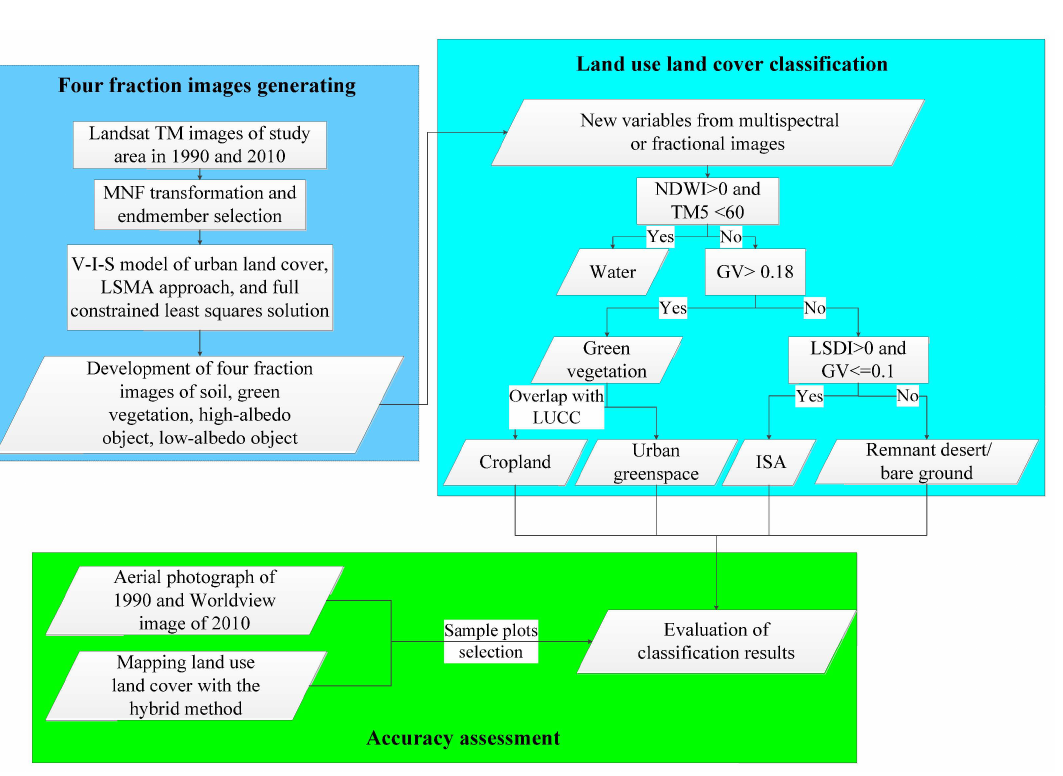
Figure 2. Flow chart of urban land cover mapping. MNF—minimum noise fraction transform; V-I-S model—vegetation—impervious surface—soil model; LSMA approach—linear spectral mixture